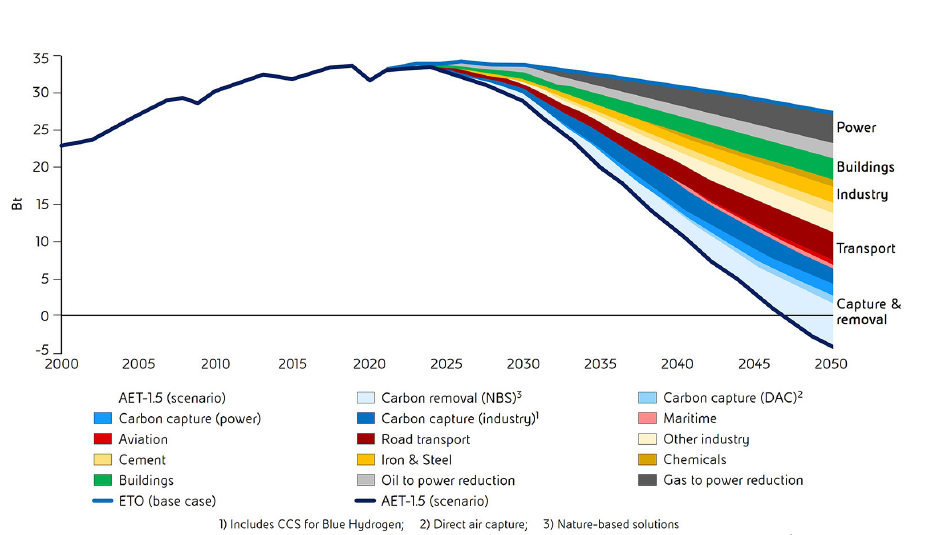
Fig. 4. – We need to deploy multiple solutions to achieve net zero emissions (Source: Wood Mackenzie, 2022